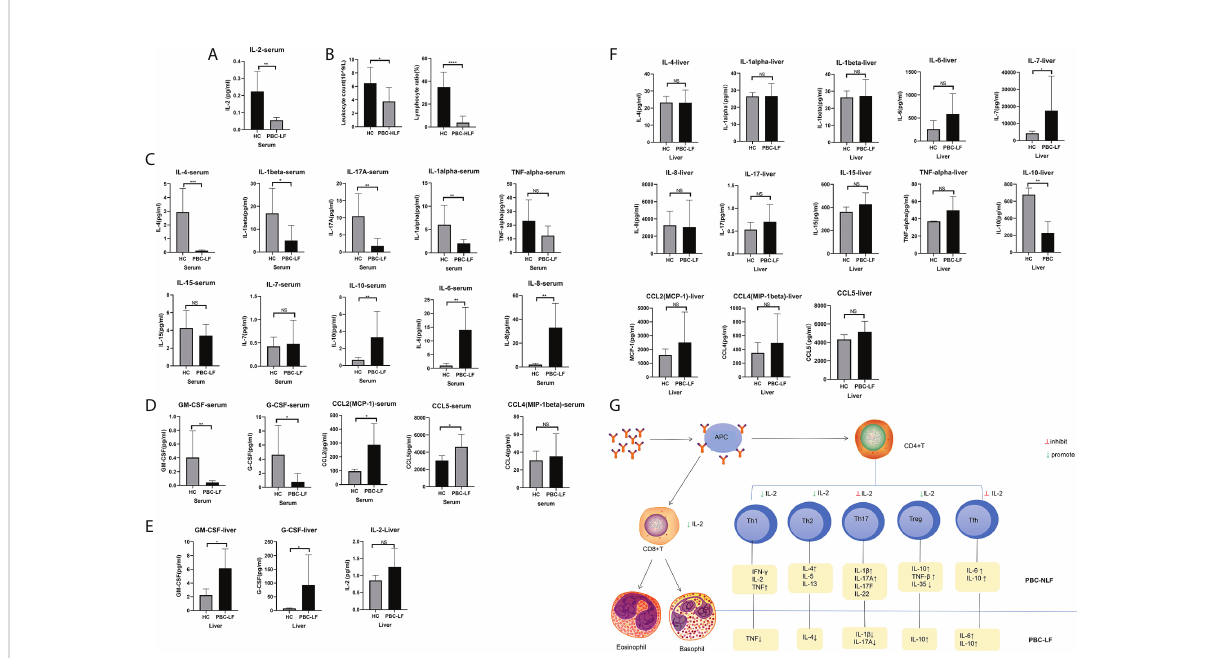
FIGURE 3 Cytokine changes in patients transplanted with advanced PBC liver failure after liver transplantation. (A) IL-2 levels in patients with advanced PBC liver failure after liver transplantation. (B) Changes in the proportion of leukocytes and lymphocytes in liver transplant patients compared to healthy controls (C) Treatment of cytokine changes in liver transplant patients ’ blood compared to healthy controls (D) Changes in colony- stimulating factors and chemokines in liver transplant patients ’ blood compared to healthy controls (E) Expression of IL-2, GM-CSF, and G-CSF in liver transplant patients ’ liver tissues compared to healthy controls (F) Changes in various cytokines in liver transplant patients ’ liver tissue compared to healthy controls. (G) PBC immune cell type changes. *P < 0.05; **P < 0.01; ***P < 0.001. NS is the abbreviation of Normal Saline, which stands for the control